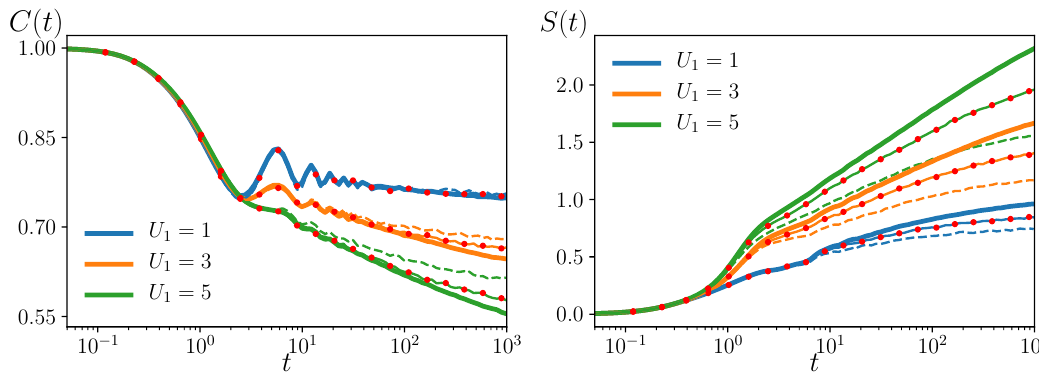
Figure 4: Ergodicity breaking for the system of spinless fermions (half-filling) with lattice sizes K = 16,18,20 (denoted respectively by dashed, dotted and thick lines), short-range interaction strength U = 1, disorder strength W = 8 and various long- range interaction strengths U . Left – the correlation function C ( t ) , Right – the en- 1 tanglement entropy S ( t ) . The quantities are averaged over more than 2000 disorder 〉 realizations, starting from randomly chosen initial Fock states | ψ 0